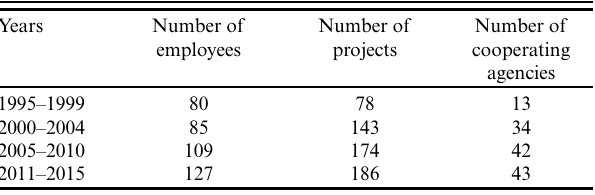
Table 1 . Staffing, number of projects, and number of cooperating agencies for the Department of Natural Resources for the Confederated Tribes of the Umatilla Indian Reservation, 1995 to